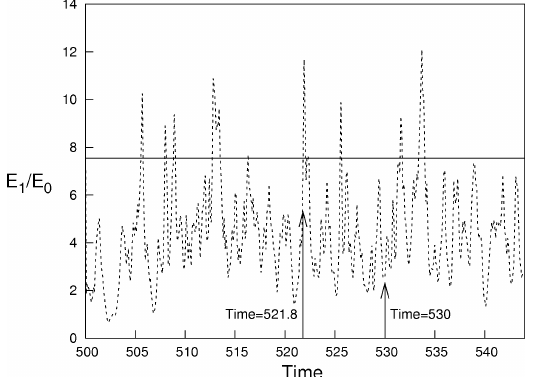
Figure 8. Behaviour of the ratio between the first mode and the zero mode of the azimuthal energy is reported for Γ = 1/2, Ra = 2 × 10 5 and Pr = 1.65. Solid line indicates the flow without bubbles and the dashed line indicates the two-way coupling.